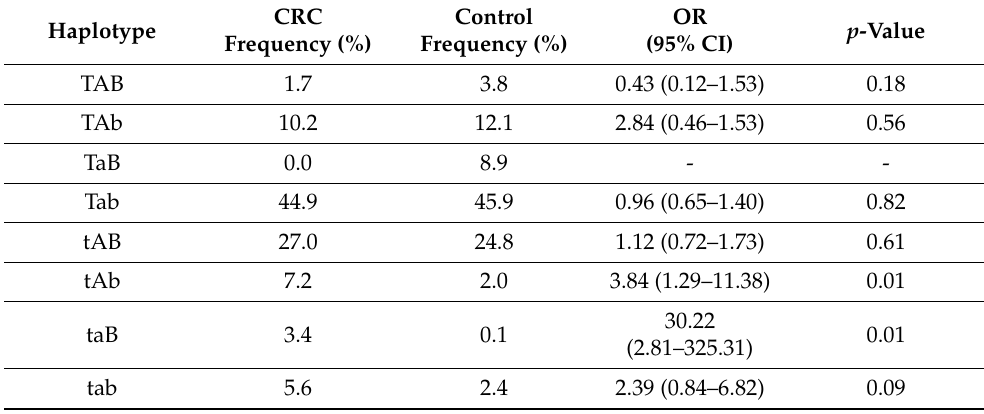
Table 6. Haplotypes with alleles in linkage disequilibrium (LD): ApaI, TaqI, and BsmI.